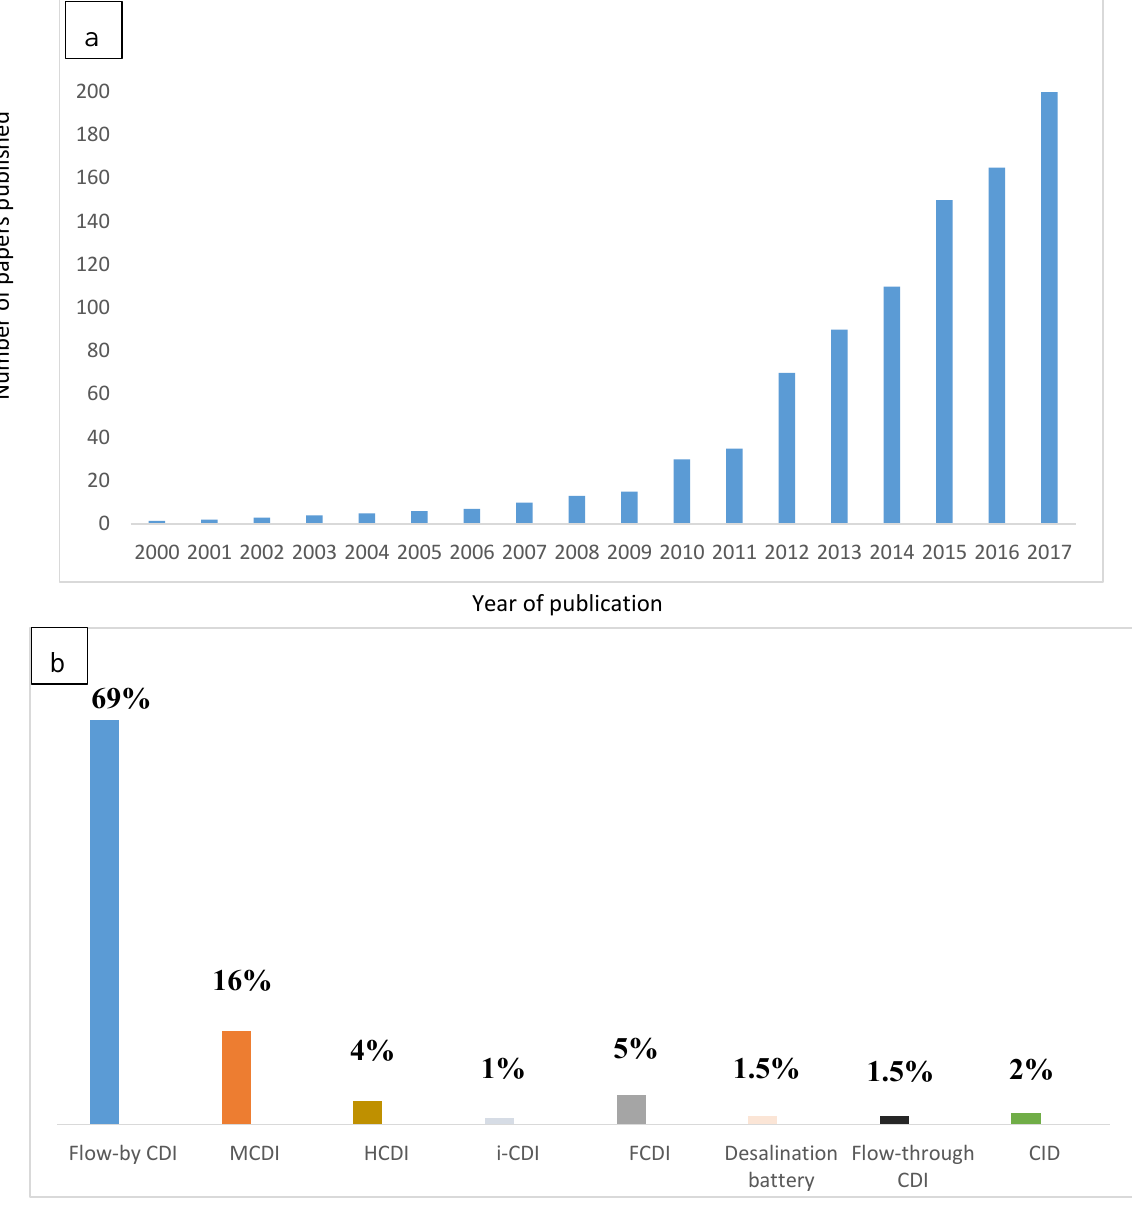
Figure 1. Advances in electrochemical technologies for desalination ( a ) in terms of published papers by Wang et al. [3] ( b ) in terms of exploitation/utilization per technology. Table 1. Progress in innovation in electrochemical desalination